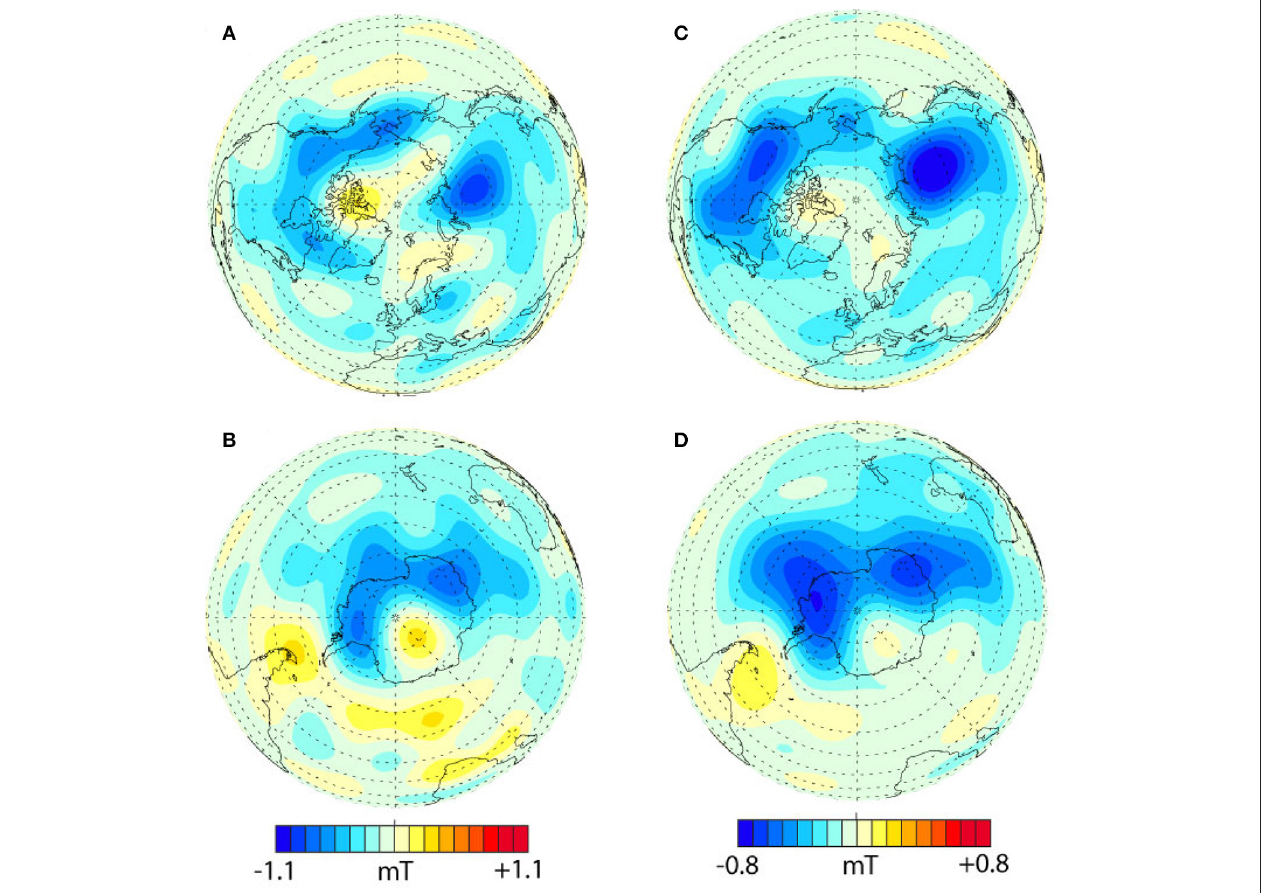
FIGURE 4 | B r cos( θ ) on the core-mantle boundary from the COV-OBS geomagnetic field model (Gillet et al., 2013). (A,B) are Northern and Southern hemisphere snapshots, respectively, at epoch 2014; (C,D) are 1840-2014 time averages of the Northern and Southern hemispheres, respectively. Contours are in millitesla, mT.